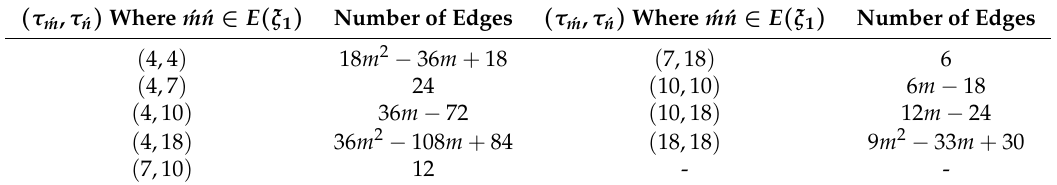
Table 1. Edge partition of third type of hex-derived network HDN 3 ( m ) , based on degrees of end vertices of each